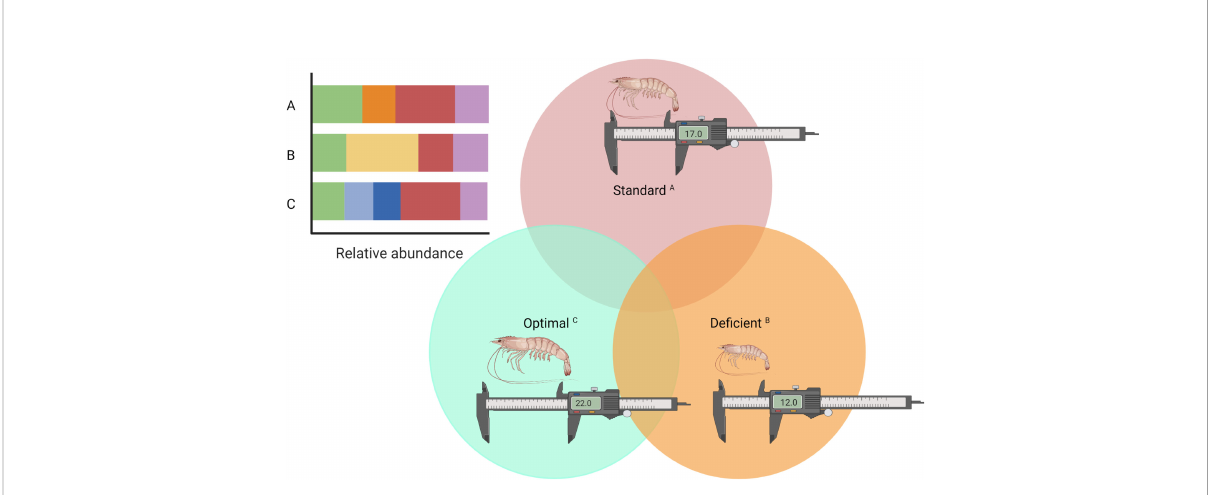
FIGURE 3 Classi fi cation of the intestinal microbiome of L. vannamei according to its bene fi ts in aquaculture production. Standard: microbiome in the natural environment (undisturbed); De fi cient: microbiome presenting with retarded growth, low survival rates, or pathology; Optimal: microbiome that provides bene fi ts over the standard to the host, favoring productivity, biosecurity and/or eco-ef fi ciency of the aquaculture system. Relative abundance can refer to phylotypes, transcripts or metabolic pathways. The letters A – C are used to relate and illustrate that each classi fi cation has different relative